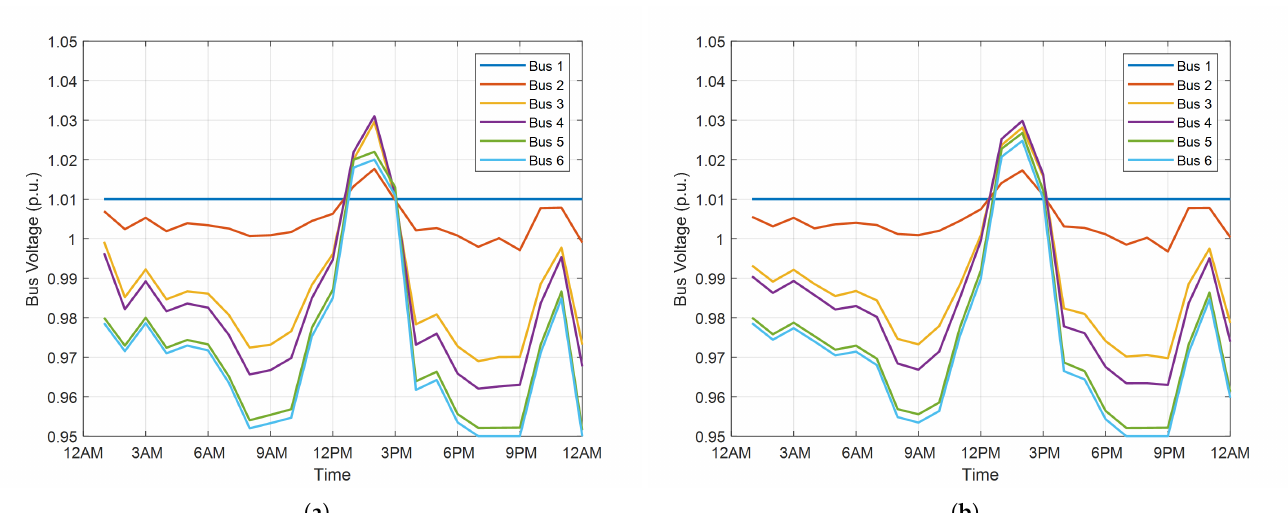
Figure 6. Bus voltage profiles in grid-connected mode. ( a ) Centralized Method. ( b ) Distributed Method.